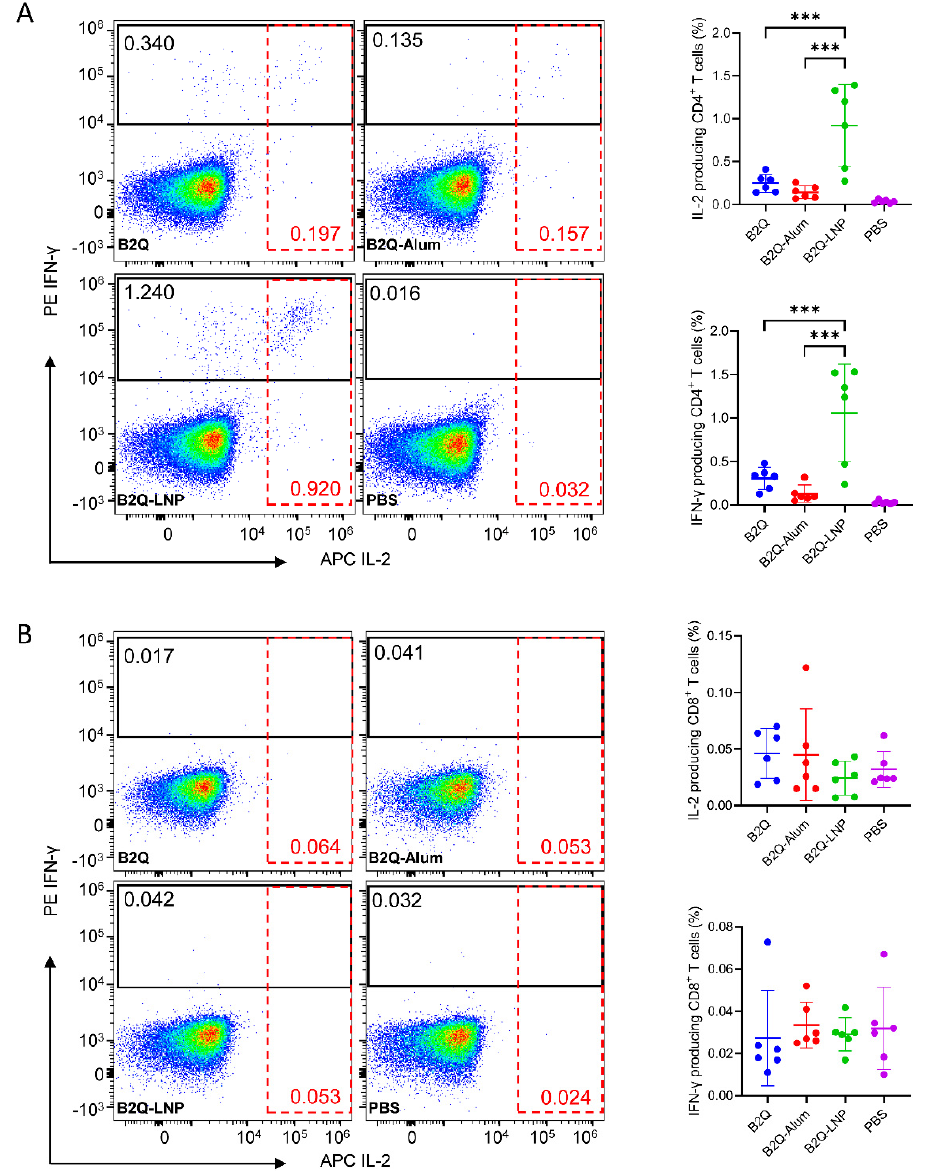
Figure 7. Flow cytometry assay assessing cytokine-producing gE-specific CD4 + ( A ) and CD8 + ( B ) T cells in mice in the LNP encapsulation study. Splenocytes from immunized mice were treated with 10 µg/mL protein gE, and after blocking with brefeldin A, IL-2- and IFN- γ -producing CD4 + ( A ) or CD8 + ( B ) T cells were detected. Pseudocolor images displaying representative results near the average value are presented in the left panel. N = 6, points represent individual mice. Data are shown as the mean and SD and were analyzed by ANOVA, with the mean of the B2Q-LNP group used as a control. *** p ≤ 0.001.